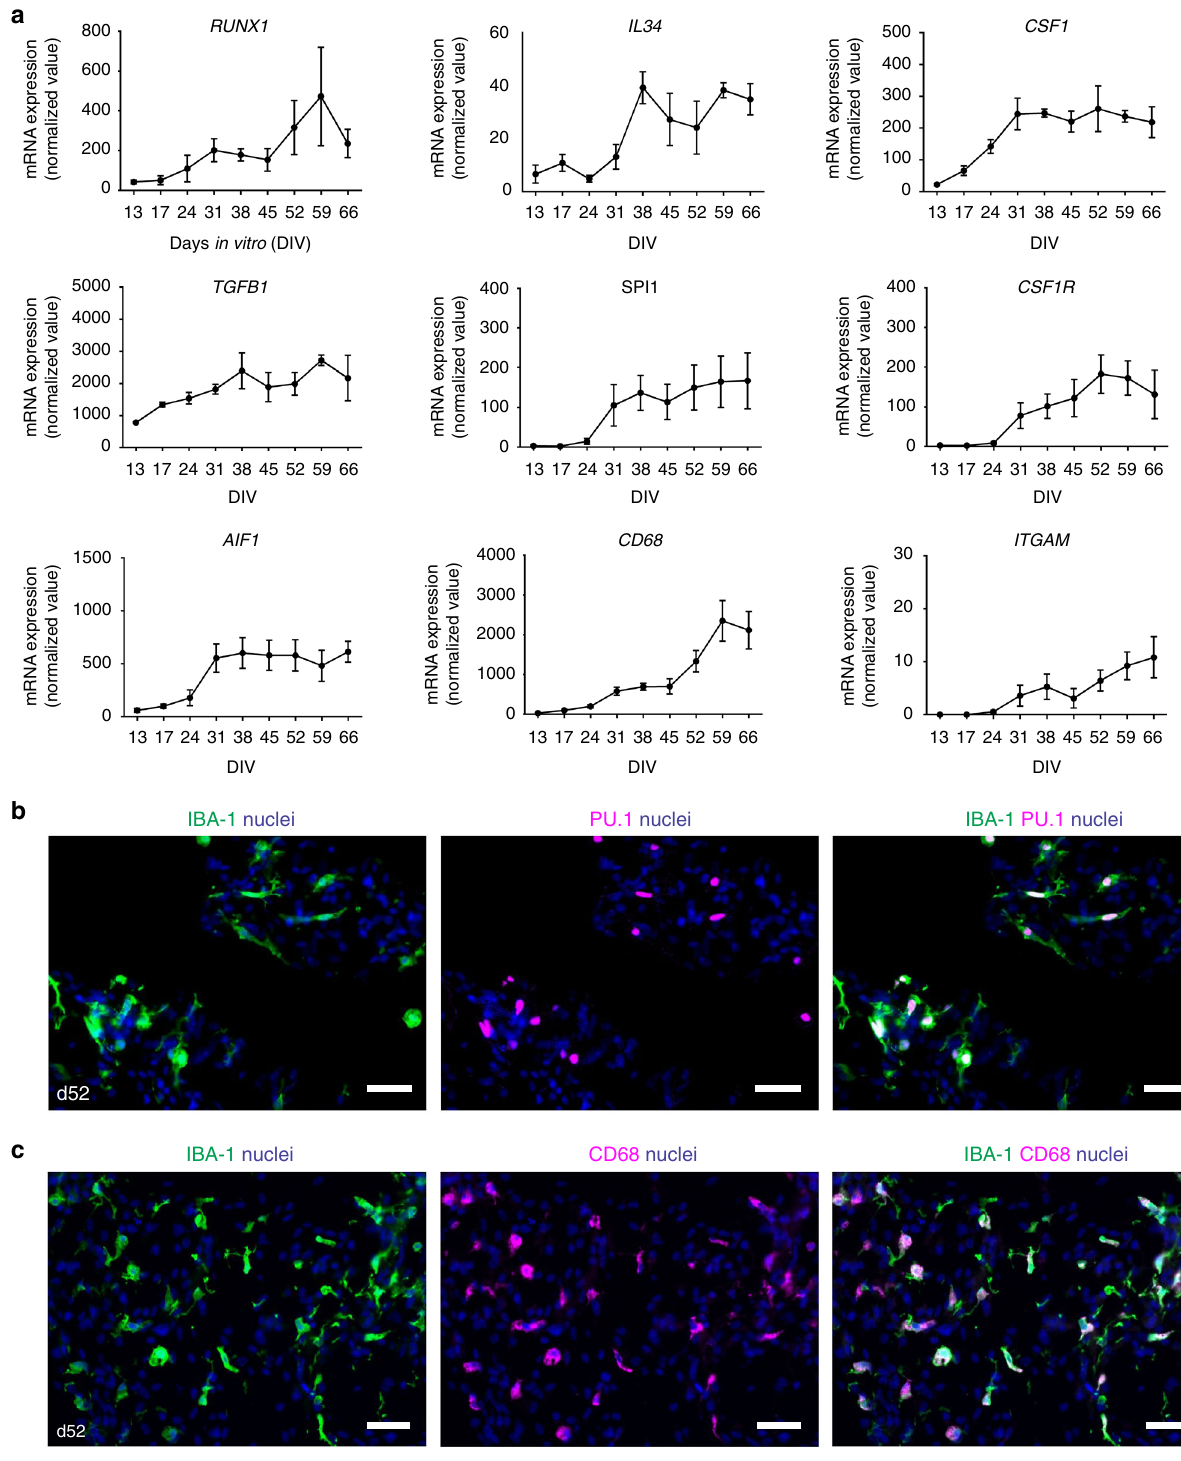
Fig. 2 Microglia-speci fi c gene and protein expression. a Time course of mRNA expression levels of early microglia markers and factors involved in microglia development in organoids assessed by qRT-PCR and normalized to the geomean of the reference genes SDHA2 and ACTB . Data points represent the mean of four batches of two organoids per batch per timepoint. All batches consisted of organoids derived from iPSC 1. Error bars represent the standard error of the mean (SEM). See also Supplementary Fig. 3a. b , c Double immunostainings of IBA-1 combined with nuclear PU.1 ( b ) and CD68 ( c ) at day 52. Representative pictures of cerebral organoids from iPSC 1 are shown. Scale bars 40 µ